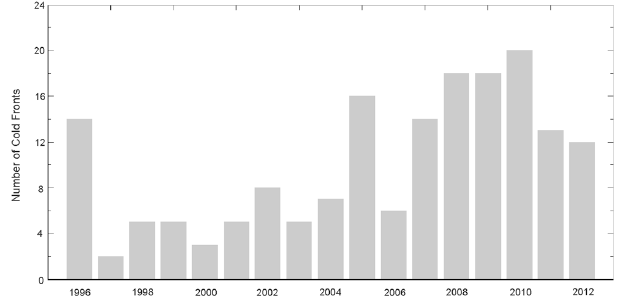
Fig. 8. Annual variation of the number of cold fronts; values were estimated using data from 1996 to 2012.